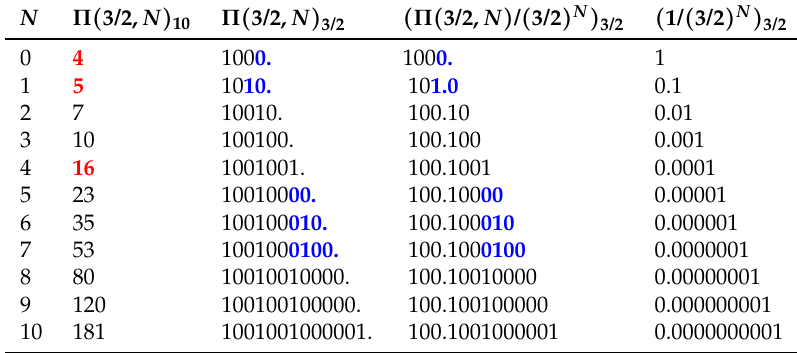
Table 4. Number of collisions Π ( 3/2, N ) given by (13) and approximation of π for b = 3/2. The first column is N . The second column is Π ( 3/2, N ) in the decimal base. The third column is the integer part of the number of collisions Π ( 3/2, N ) written in the base 3/2. The fourth column is the number π with N digits in the fractional part in the base 3/2. The fifth column gives the systematic error according to Equation (55). The cases where approximation (14) fails as compared to (13) are highlighted by red. The blue bold digits are predicted incorrectly by the Galperin